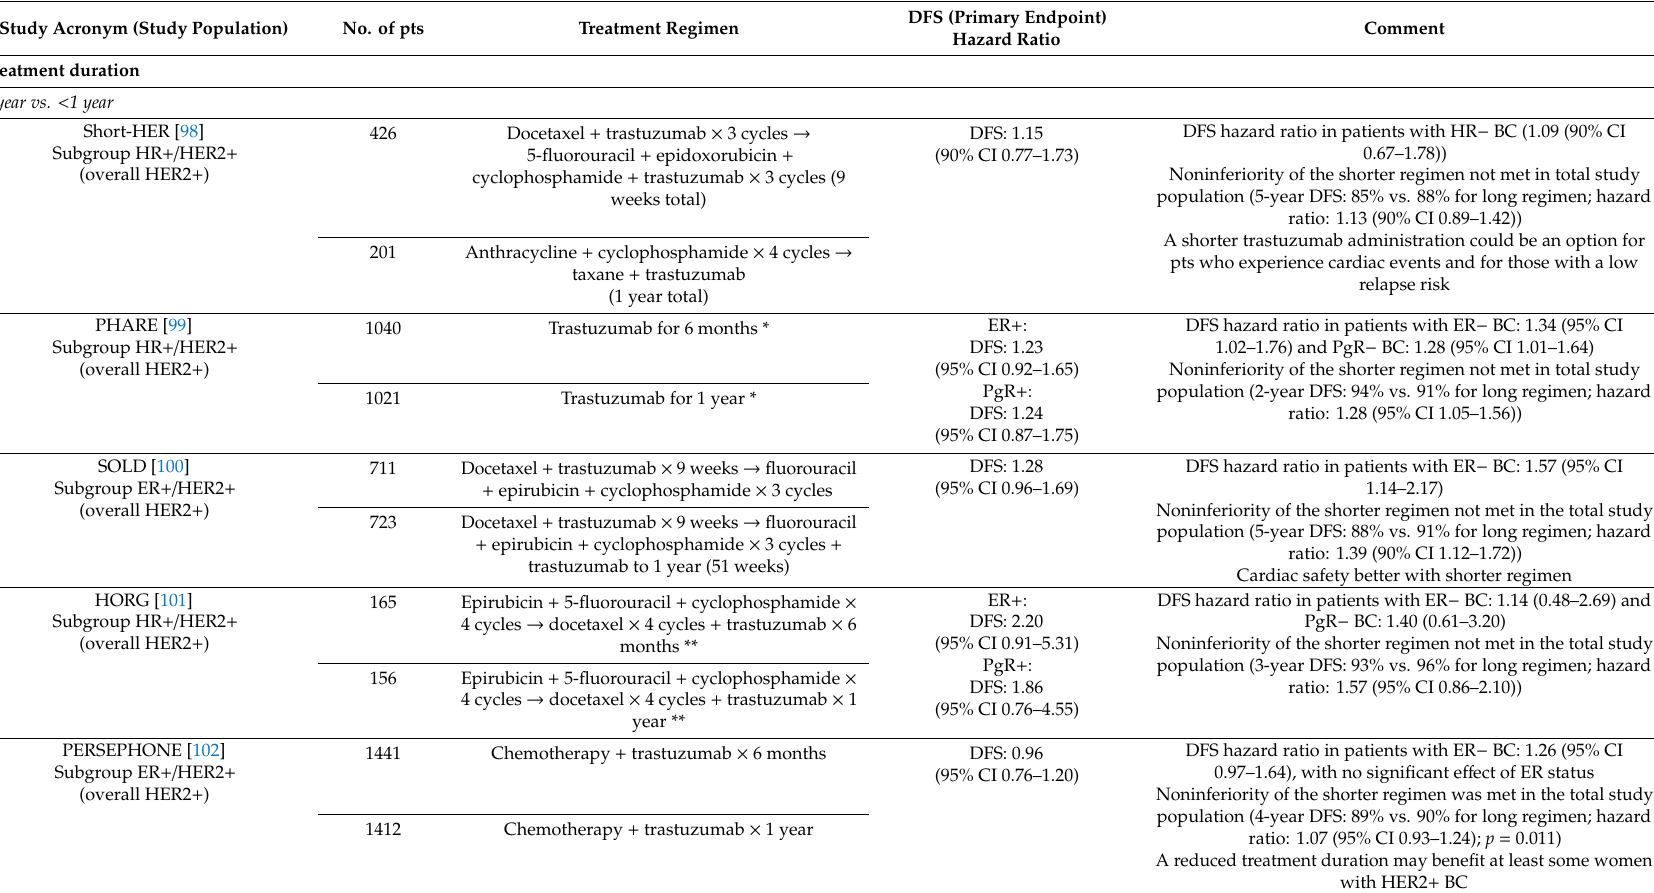
Table 3. Phase II and III trials in the adjuvant setting, including patients with HR +/ HER2 + breast